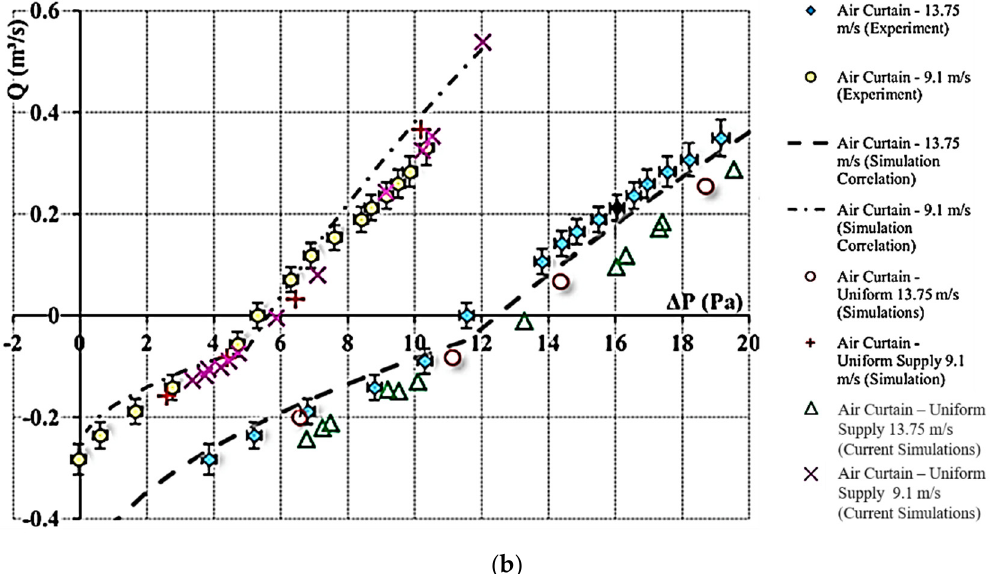
Figure 8. ( a ) experimental setup ( b ) Q– Δ P relationship comparisons among the CFD simulation results in this study and experimental and CFD simulation results from [30].